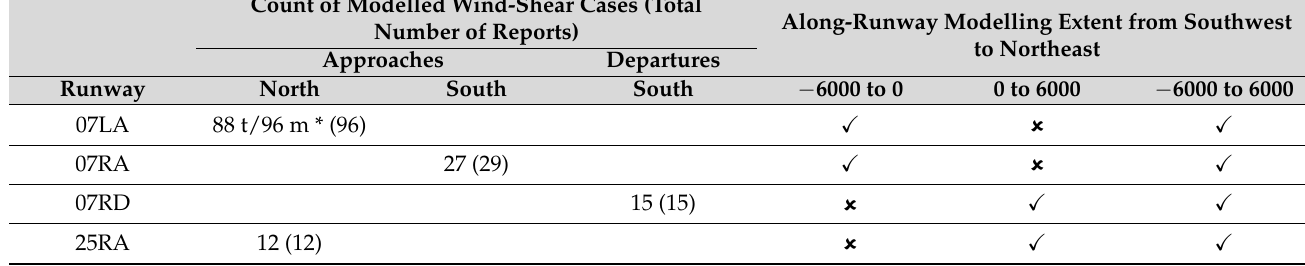
Table 4. Summary of the subset of modelled cases corresponding to pilot wind-shear reports; * the number of cases differs for typical and maximum’ inversion-layer wind-speed cases due to the typical cases requiring more comprehensive meteorological-data input parameters than the ‘maximum cases; runway corridors 07LD, 25LA, 25RA, and 25RD were excluded from the modelling due to insufficient corresponding pilot wind-shear reports.